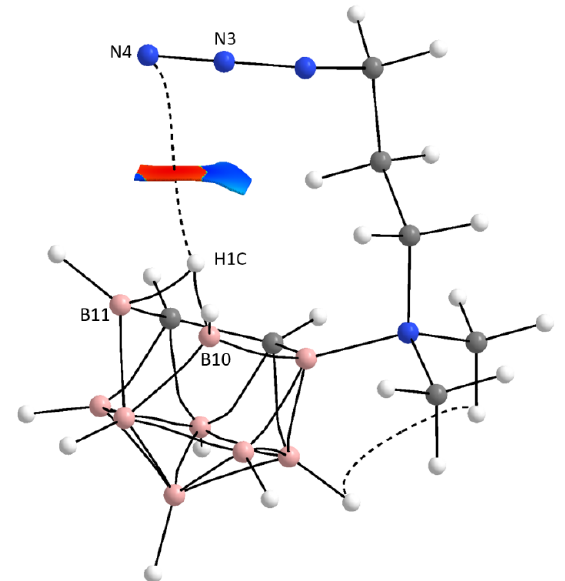
Figure 3. The atomic connectivity graph of the isolated molecule of 2 determined by means of the “Atoms in Molecules” theory and the sign(λ 2 )·ρ( r ) distribution mapped onto the 0.4 reduced density gradient isosurface between the H1C, N4 and N3 atoms (from −2.6e −3 a.u. in red to +2.6e −3 a.u. in blue). Bond paths for intramolecular non-covalent interactions are shown by dashed curves.